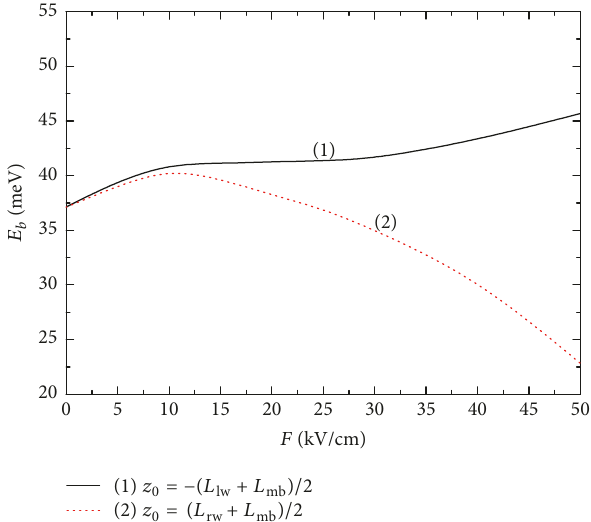
Figure 4: The ground-state donor binding energy 𝐸 𝑏 in a ZB In 𝑥 Ga 1−𝑥 N/GaN symmetric coupled QDs as a function of the middle barrier width 𝐿 mb for 𝑅 = 10 nm, 𝐿 lw = 4 nm, 𝐿 rw = 4 nm, 𝐹 = 30 kV/cm, 𝜌 = 0 for different impurity positions 𝑧 0